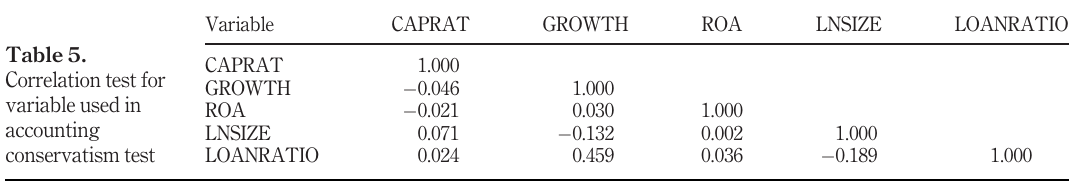
Table 6. Correlation test for variable used in